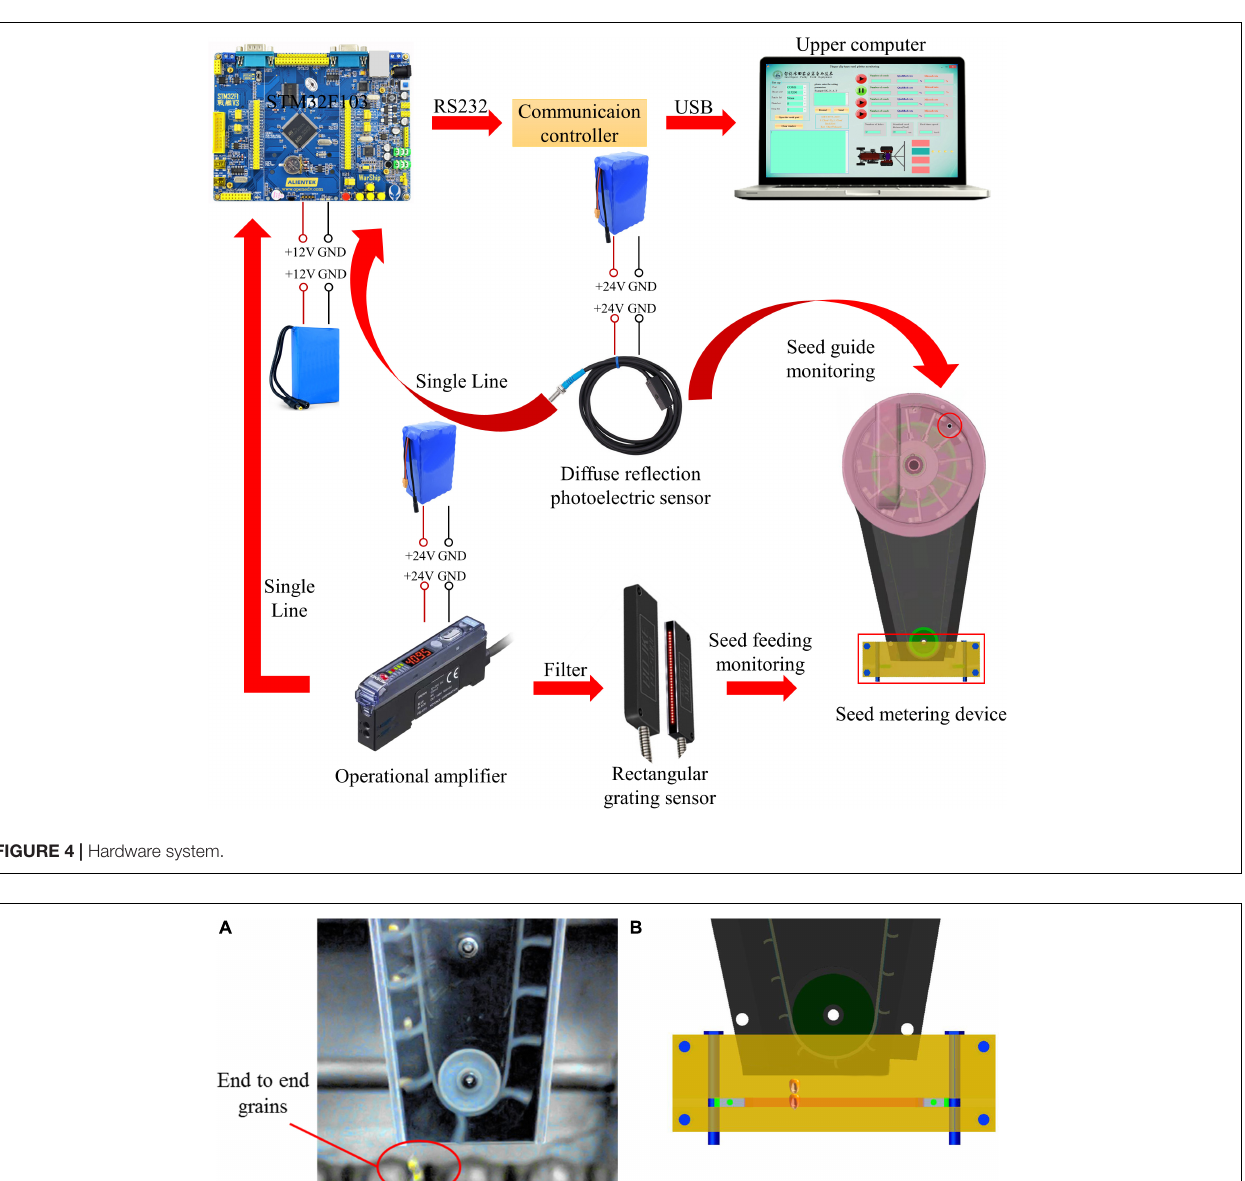
FIGURE 5 | Schematic diagram of multiple seeding. (A) Rseeding in high-speed camera observation. (B) Principle of reseeding